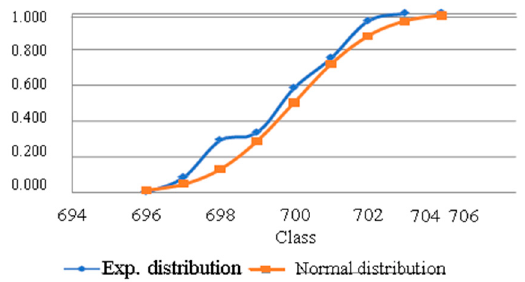
Figure 5. Control charts for a sample with 36 elements.